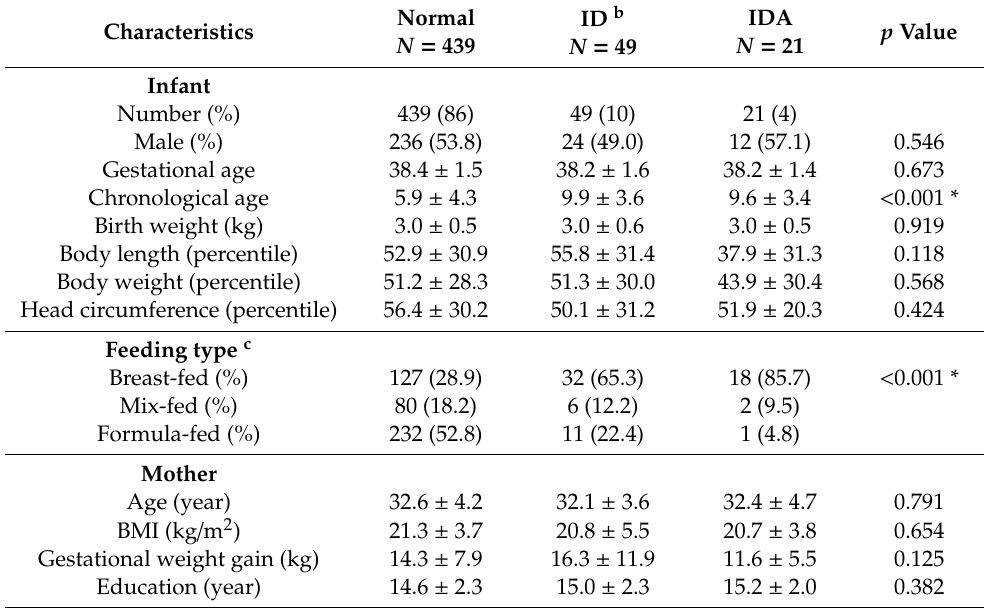
Figure 1. Flowchart of the enrolment of infants. Table 1. Demographic characteristics of subjects diagnosed with iron deficiency (ID) or iron deficiency anemia (IDA) in the first year of life a